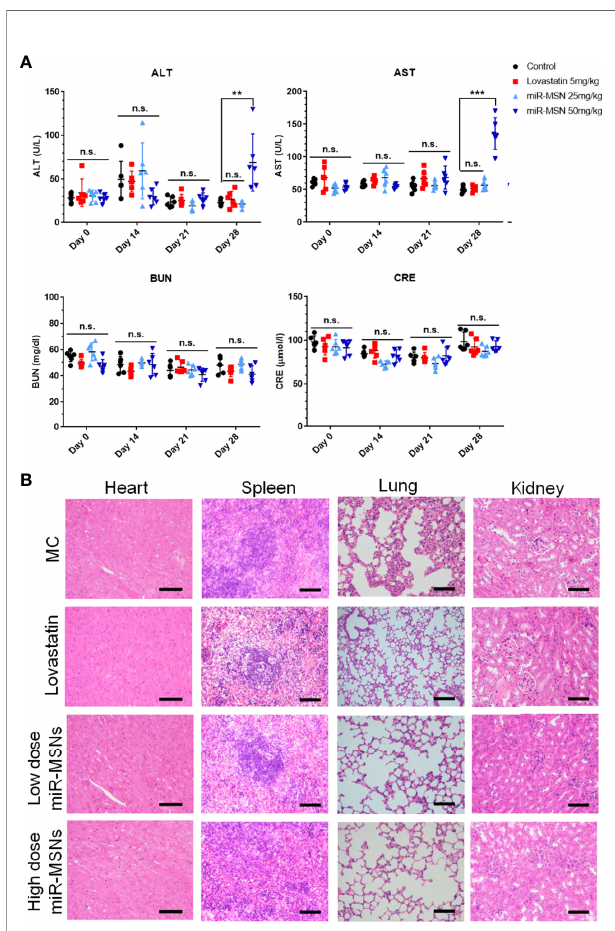
FIGURE 7 | Safety analysis. n=6. (A) Concentration of AST, ALT, BUN, and CRE in serum on Day28; (B) Representative tissue sections of mice stained with HE on Day28. Scale bar = 50 µm. **p < 0.01, ***p < 0.001. n.s., no signi fi